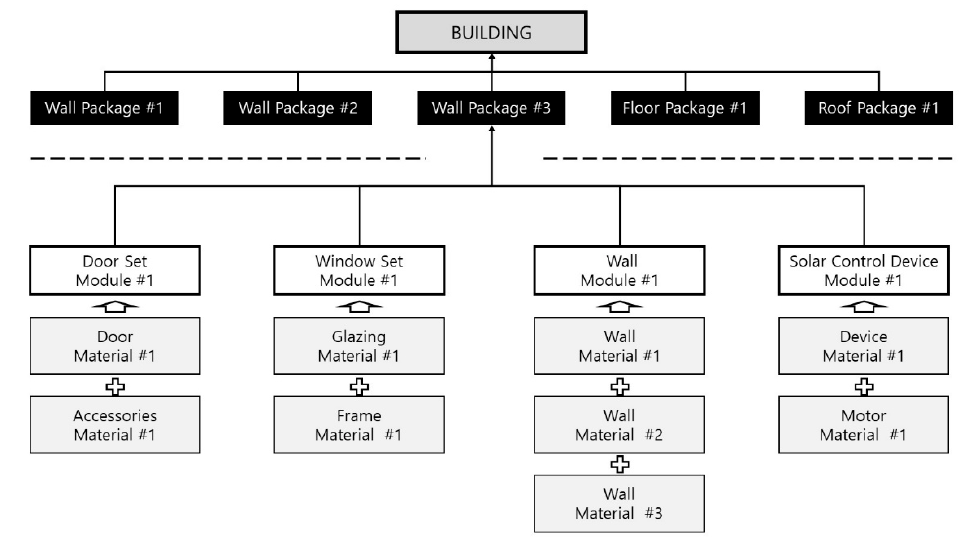
Figure 2. Passive package composition.